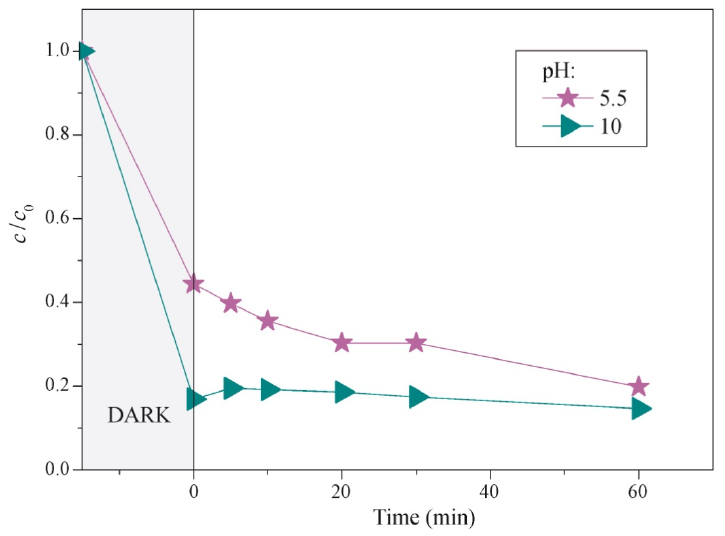
Figure 7. Influence of pH on the removal efficiency of CIP (0.05 mmol/dm 3 ) using TMO (1.0 mg/cm 3 ) under SS.